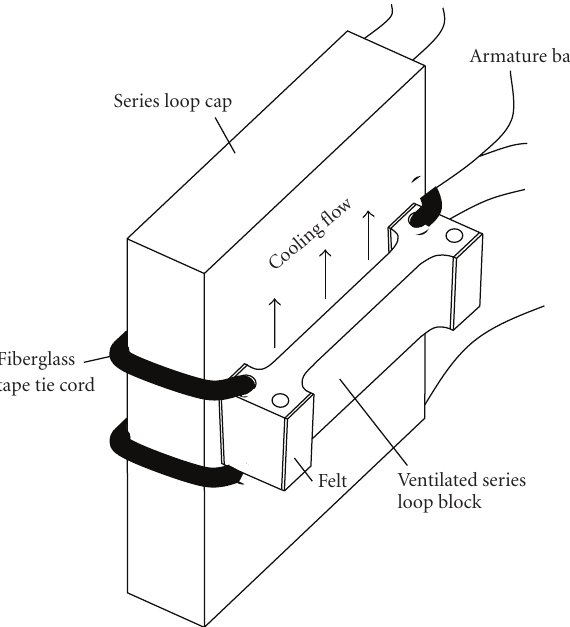
Figure 10: Assembly of ventilated series loop block with series loop cap.